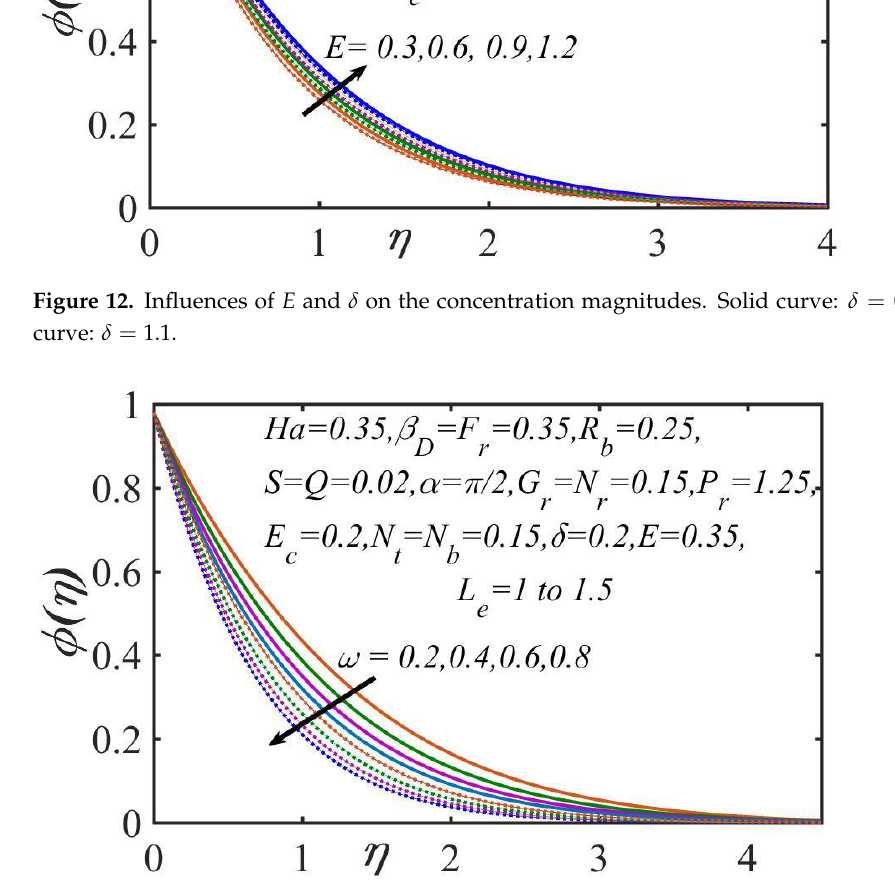
Figure 13. Impact of 𝜔 and 𝐿 𝑒 on the concentration magnitudes. Solid curve: 𝐿 𝑒 = 1 ; dotted curve: 𝐿 𝑒 = 1.5 .